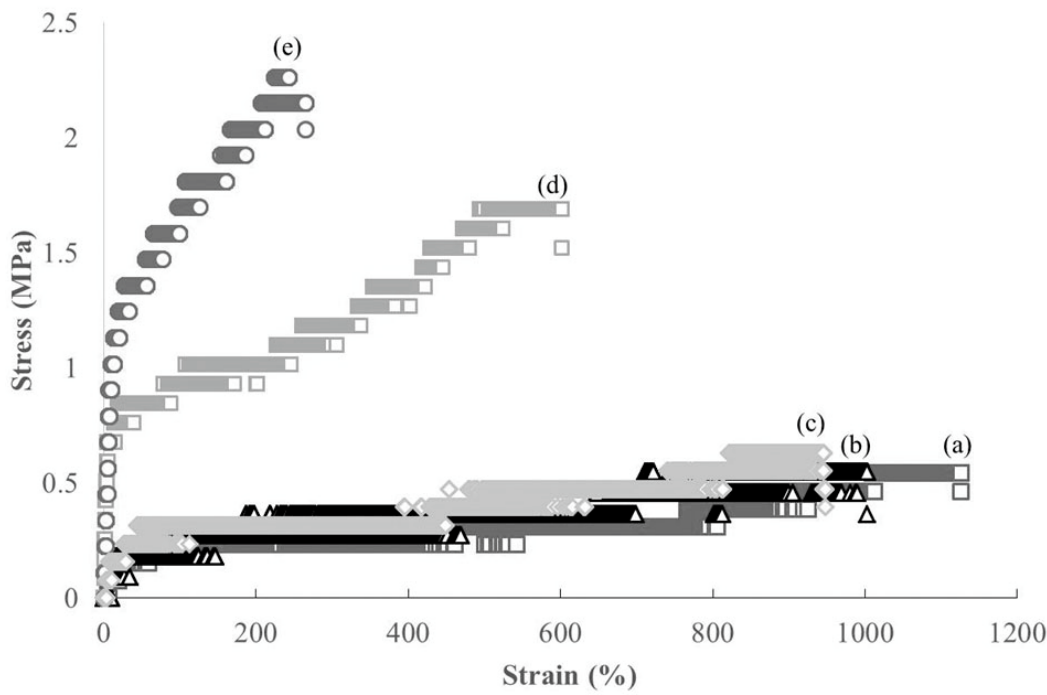
Figure 6. Stress – strain curves of ( a ) NR; and ( b – e ) self-assembled CNF-NR composite sheets (CNF:NR (weight ratio) = 0.01, 0.02, 0.1, 0.2:1, respectively) under tensile mode.